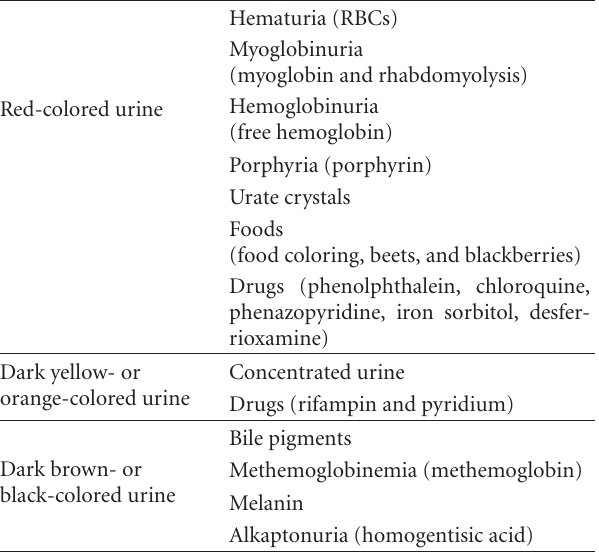
Table 2: Causes of discolored